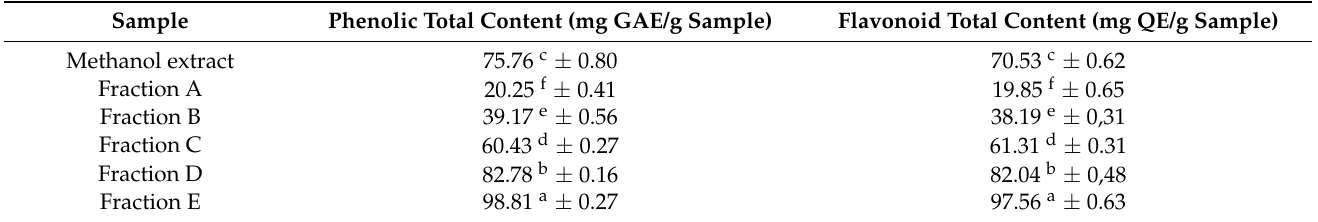
Table 3. The total phenolic and flavonoid content of the methanol fraction of Patiwala ( Lantana camara )